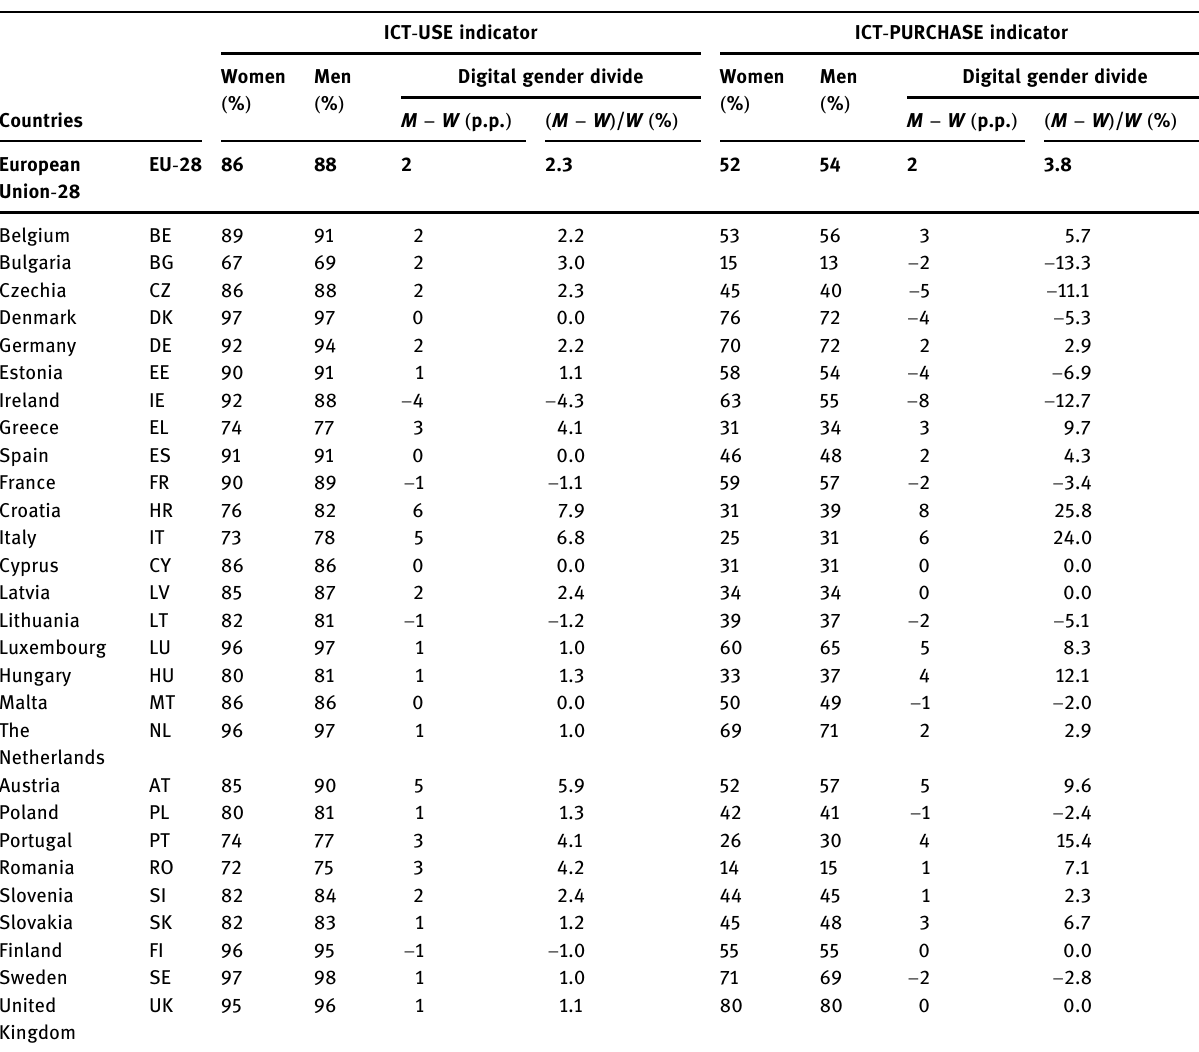
Table 1: ICT indicators and the digital gender,